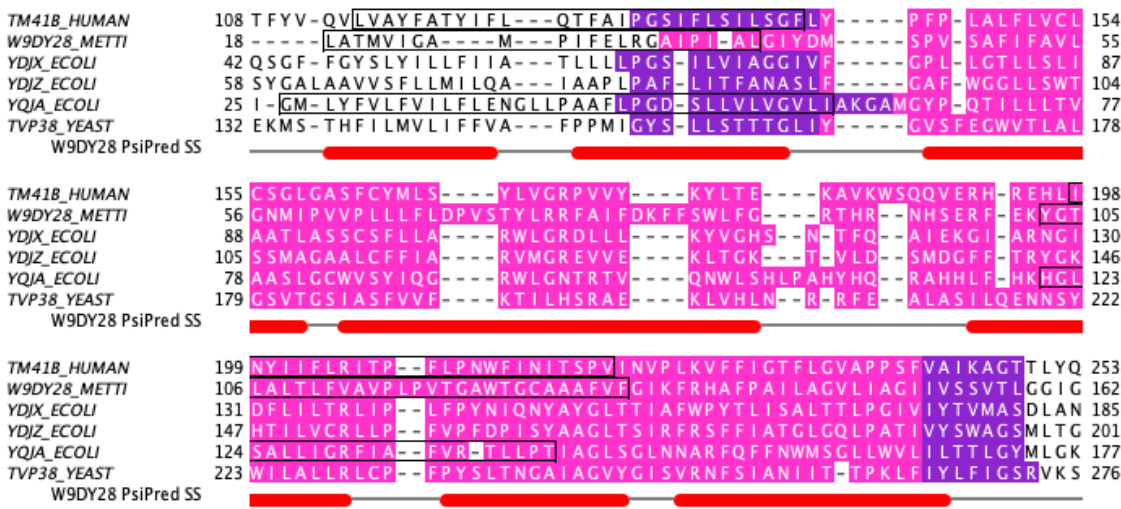
Figure 1. Multiple Sequence Alignment for query protein selection listed in Table 1. Magenta highlights the regions matched by HHpred to the PF09665 Pfam domain while purple is used for additional residues included in the PF09335 Pfam domain matches. The black boxed regions represent the locations of the putative re-entrant loops as identified by the modeling of the respective proteins. The secondary structure for the archaeal W9DY29 sequence (Mt2055) is also depicted with the relative positions of alpha helices shown as red blocks.